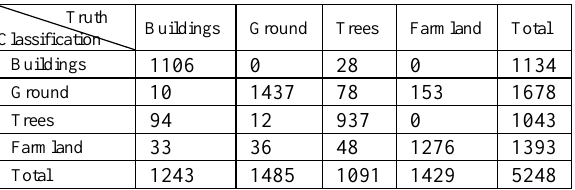
Table 1. Confusion matrix of the classification results based on SVM method